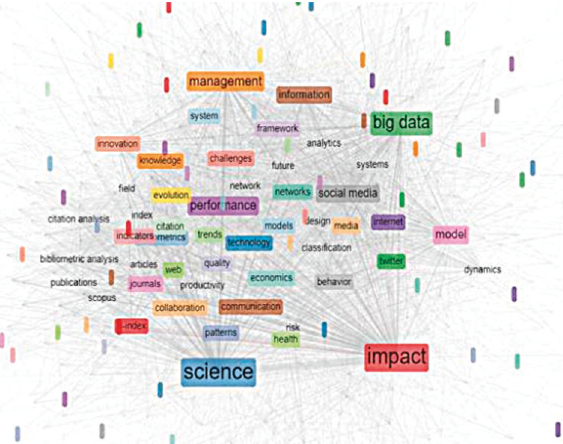
Figure 11: 2016–2020 cooccurrence network.